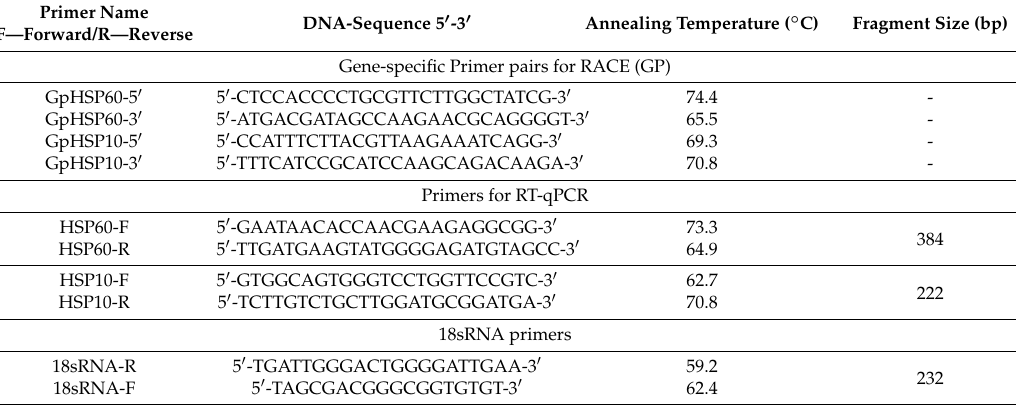
Table 1. Sequences of primers used in the present